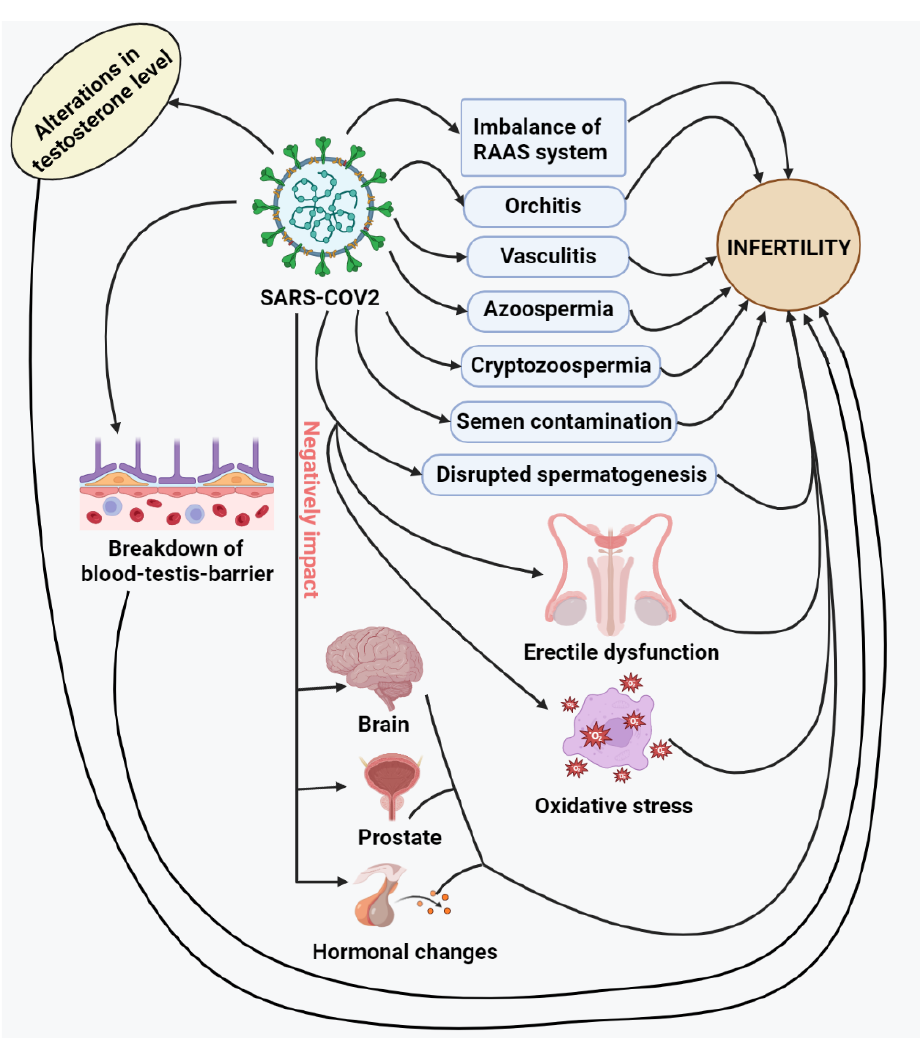
Figure 2. This figure demonstrates the action of SARS-CoV-2 on various organs such as the brain, prostate, and other organs leading to infertility. This diagram also describes that SARS-CoV-2 re- sults in an imbalance of the RAAS system, orchitis, vasculitis, azoospermia, cryptozoospermia, se- men contamination, disrupted spermatogenesis, erectile dysfunction, and oxidative stress, all